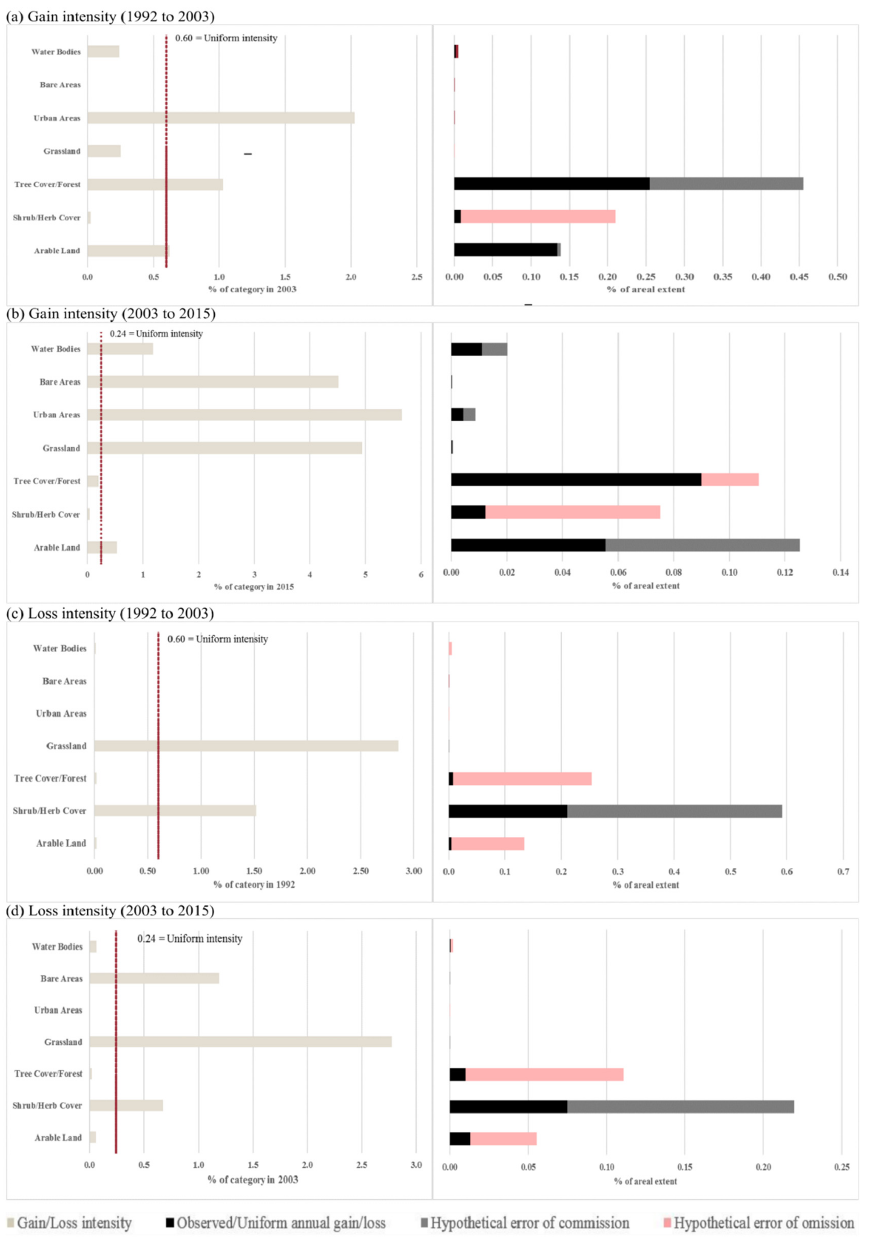
Figure 3. ( a – d ) Intensity Analysis for category-level changes for each land category during the two time intervals for the study area showing the observed gain and loss intensities for each category (left figures), and the percentages of area that changed category over the interval (right figures).